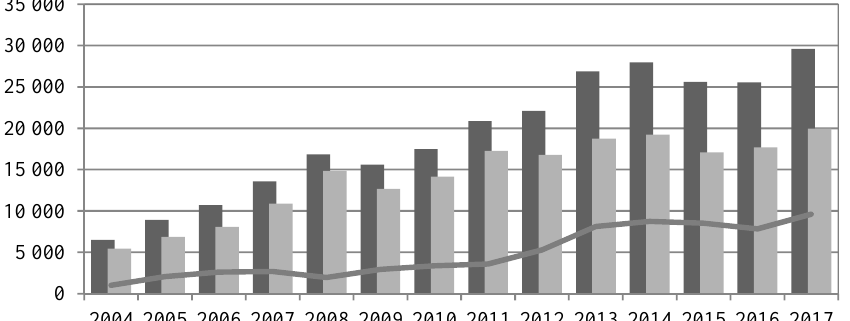
Figure 2. Foreign trade in agri-food products of Poland in the years 2004–2017, in million